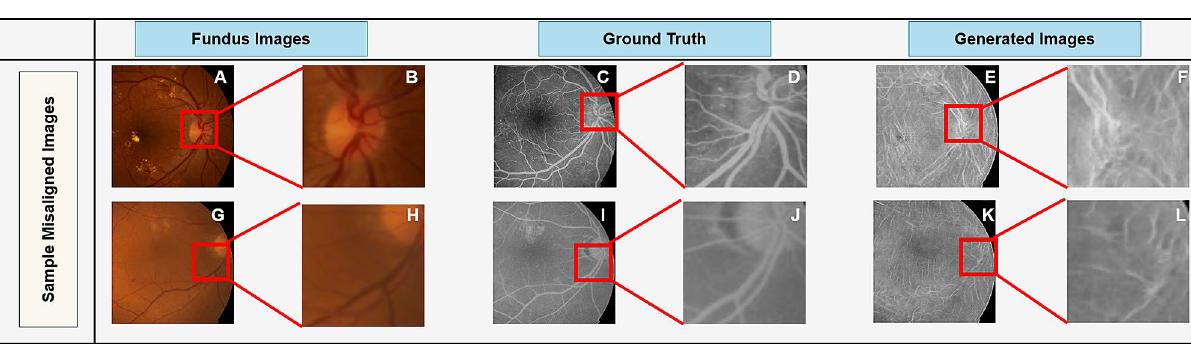
Figure 3. Results of training on unaligned pairs of fundus and angio images. Original fundus images ( A , G ) are not aligned with the FA images ( C , I ), and as a result the generated images ( E , K ) are deteriorated. ( B , D , F , H , J , and L are the magnified views of red boxed regions in A , C , E , G , I , and K ,